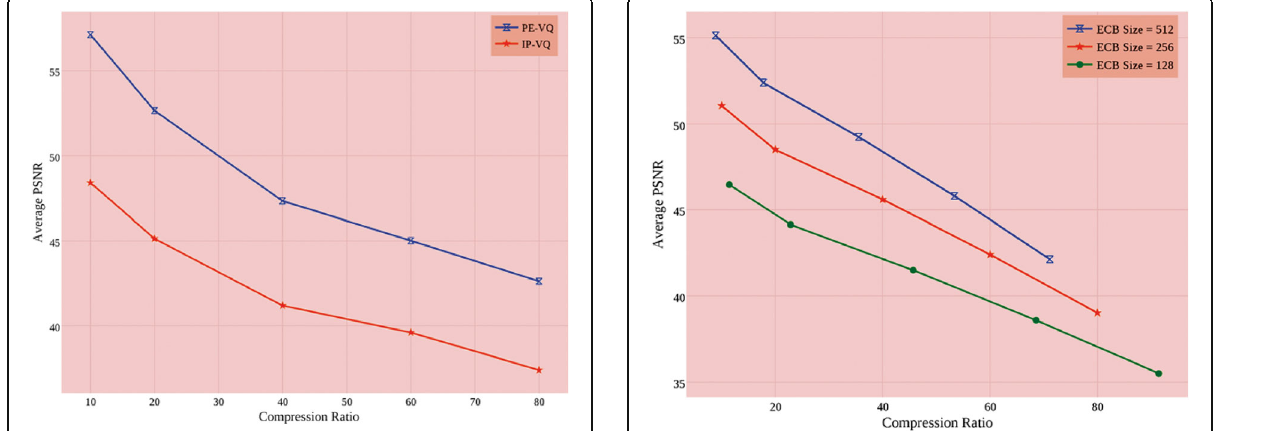
Fig. 12 Comparison of PE-VQ and IP-VQ methods for DB1 with ECB = 256